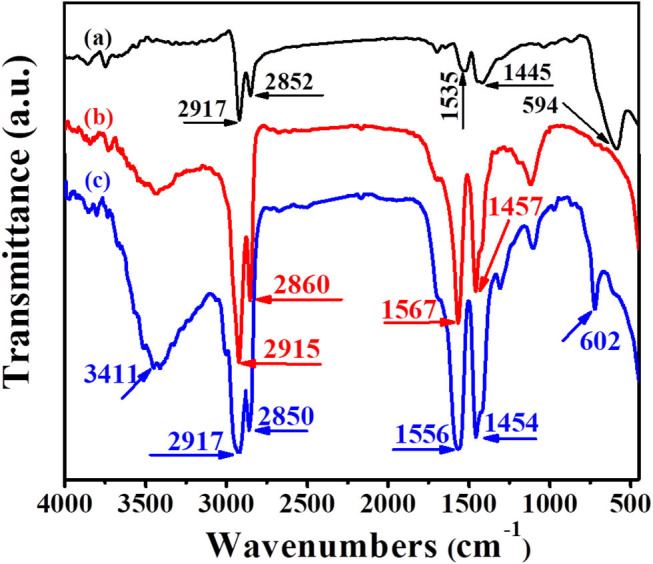
Fourier transform infrared (FTIR) spectra of Fe3O4
(a), UCNPs (b), and UCNPs/Fe3O4@h-C nanocomposites (c).